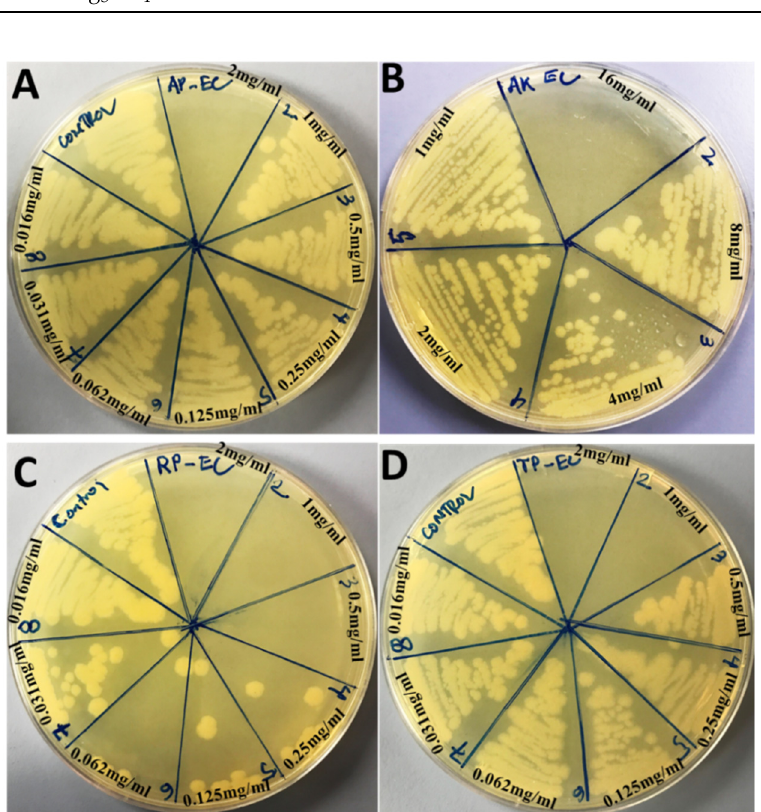
Figure 3. MHA plates showing MBC values for E. coli ATCC 25922. Plate ( A ) showing MBC value of 2 mg/mL for Ag 3 PO 4 , ( B ) 16 mg/mL for Se-Ag 3 PO 4 , ( C ) 0.5 mg/mL for Ag-Ag 3 PO 4 , and ( D ) 1 mg/mL for Ta-Ag 3 PO 4 , respectively.